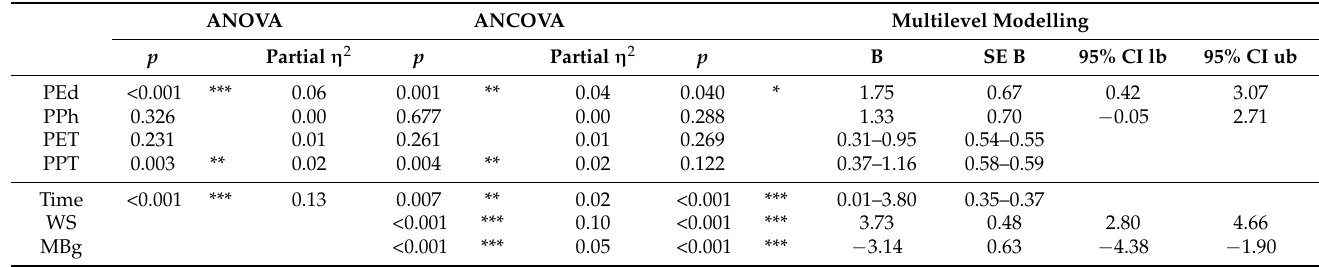
Table 2. Results of analysis of variance. analysis of covariance and multilevel modelling in comparison. ANOVA ANCOVA Multilevel